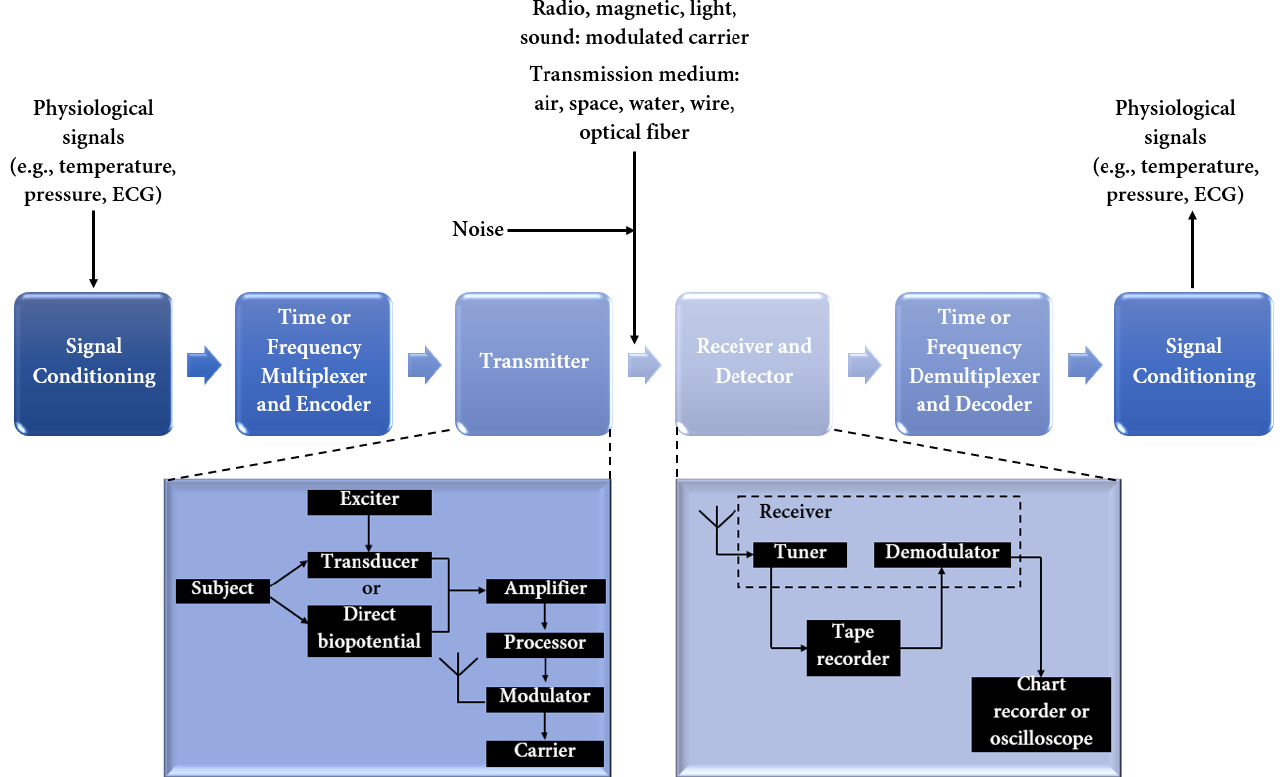
Figure 2. Block diagram of a biotelemetry system. Created based on information from